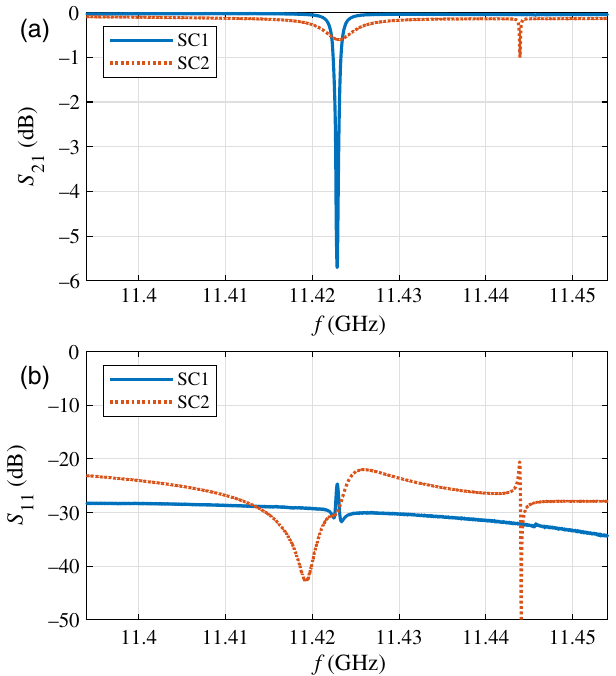
FIG. 11. Transmission (a) and reflection spectrum (b) of the storage cavities after tuning.